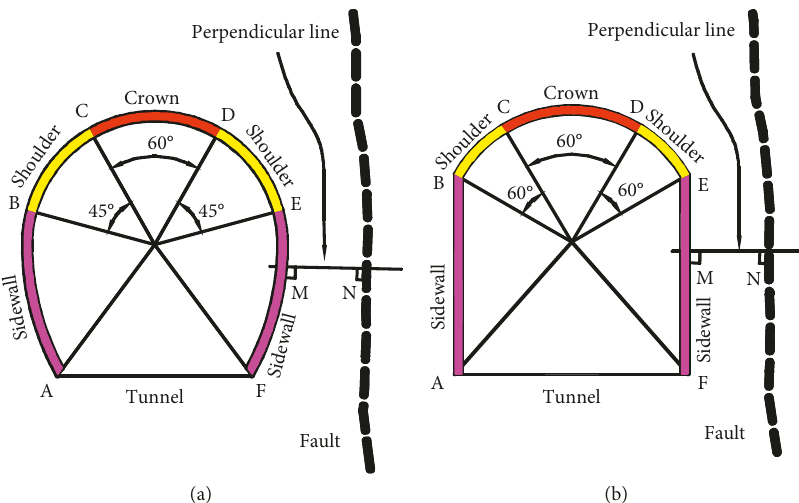
Figure 1: Mining tunnel, fault, and fault distance: (a) mining tunnel with the shape of horseshoe; (b) mining tunnel with shape rectangular conduit with circular upper